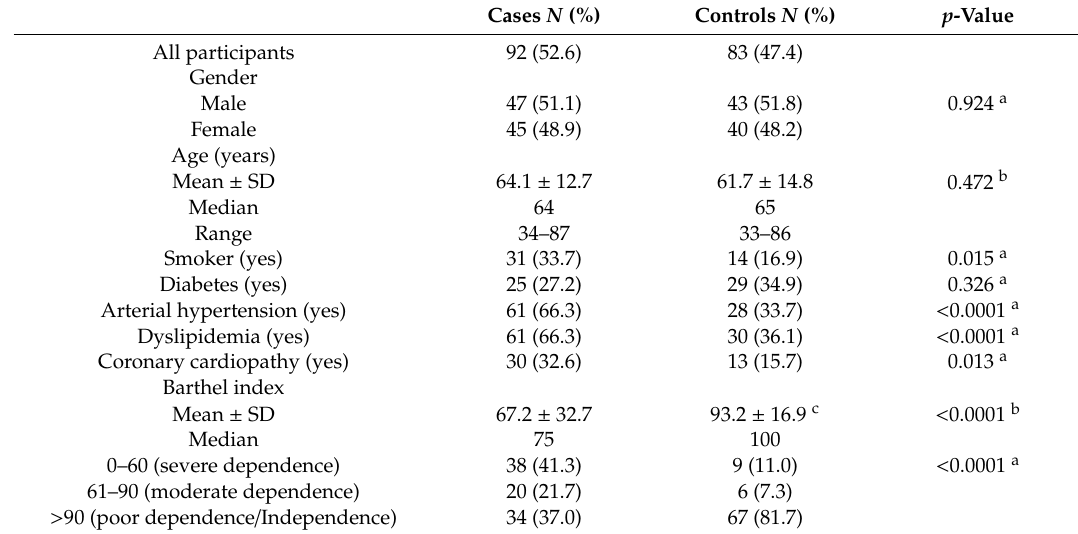
Table 1. Demographic characteristics of study